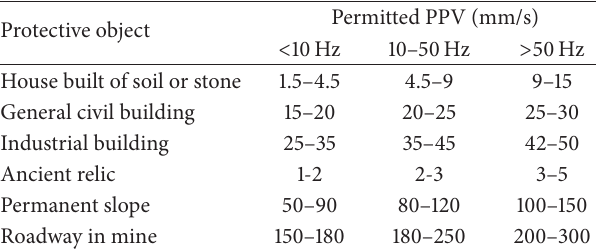
Table 4: Blasting induced vibration permitted according to Chinese